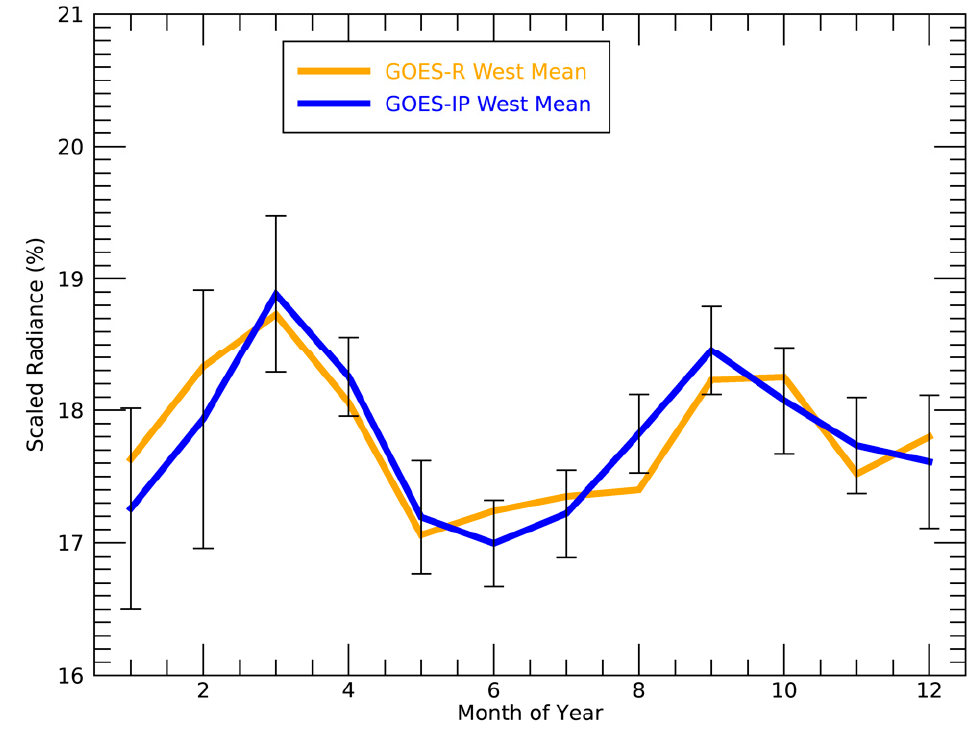
Figure 4. Same as Figure 3 but for GOES-West, where GOES-R reference is GOES-17. Table 2. Monthly means and standard deviations (SD) of the full-disk scaled radiances for GOES- West and GOES-East used as the reference values and computed from GOES-R. The observed stand- ard deviations computed from the GOES-IP series that are used in the fitting process are also shown. GOES-West Ref- erence Mean (%) GOES-West Ref- erence SD (%)